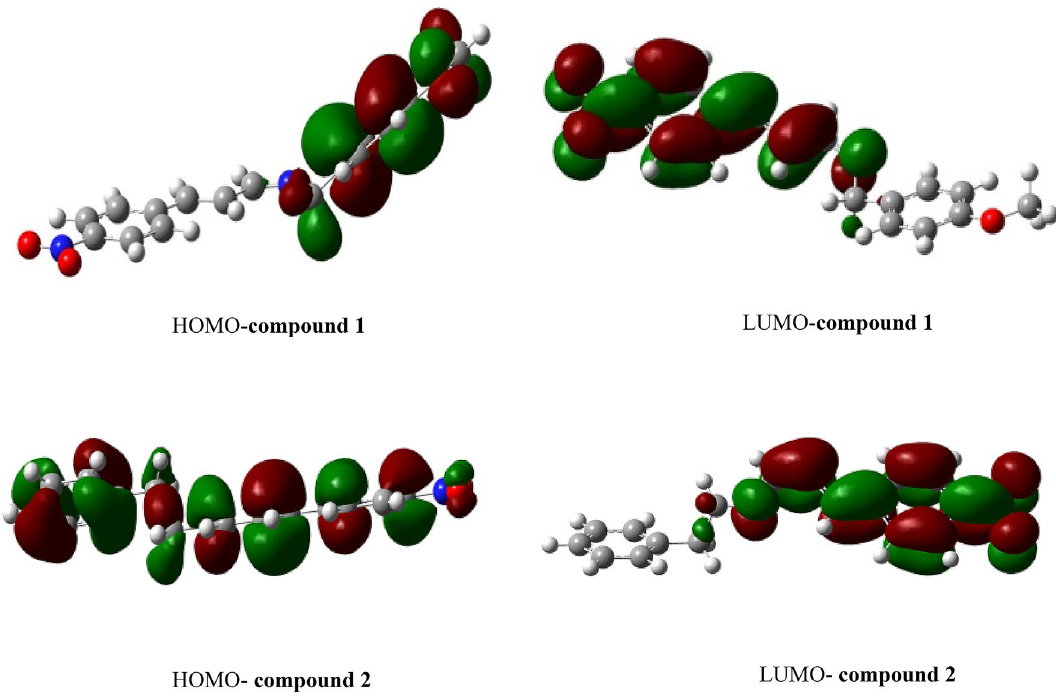
Figure 2. 3D plots of HOMO and LUMO for the